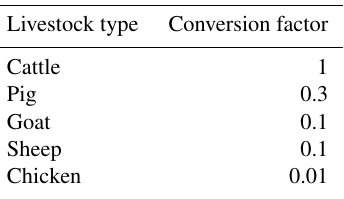
as ducks, horses, camels and bees are not available. How- Table 1. Conversion factors for different livestock types. Source: Eurostat